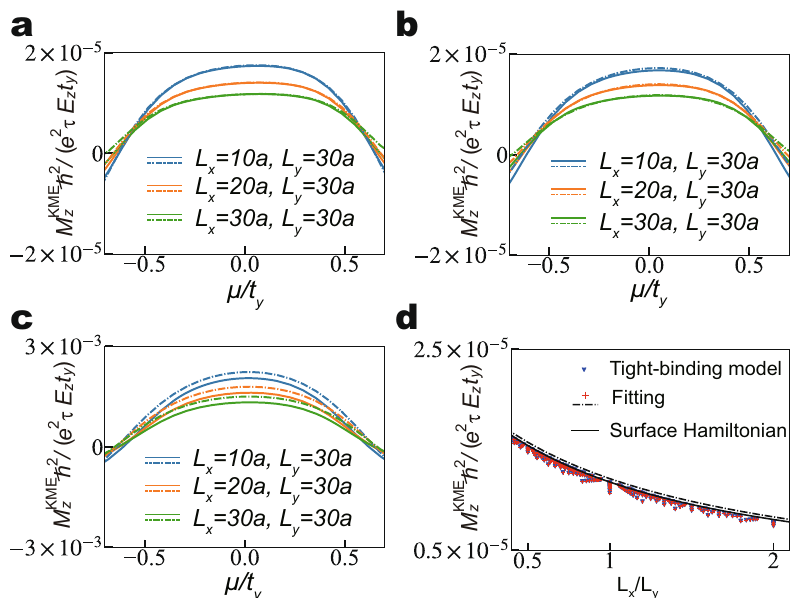
Fig. 4 Kinetic magnetoelectric effect (KME) in one-dimensional systems. a – c KME is calculated from two different methods; one is a direct calculation by Eq. (2) (solid lines) and the other is by a combination of calculation results for surfaces along xz and yz planes based on Eq. (7) (dashed lines). Parameter values are ( a ) t x = t y = m = b x = b y , t 3 = 0.001 t y and t 4 = 0.15 t y , ( b ) t x = b x = 1.1 t y , t y = b y = m , t 4 = 0.15 t y and t 3 = 0.001 t y , and ( c ) t x = t y = m = b x = b y , t = 0.15 t y and t = 0.1 t y . The results are shown for L x = 10 a (blue), L x = 20 a (orange), and L x = 30 a (green), while L y is fi xed to be 30 a . d Dependence of 4 3 the KME on the aspect ratio within the xy plane with parameters t x = b x = 1.1 t y , t y = b y = m , t 4 = 0.15 t y , t 3 = 0.001 t y , and μ = 0. Blue points represent the result of direct calculation by Eq. (2) for various system sizes. With parameter values t x = b x = 1.1 t y , t y = b y = m , t 4 = 0.15 t y , t 3 = 0.001 t y , and μ = 0, we calculate the KME with various system sizes from Eq. (2). The system sizes are ( L x , L y ) ∈ {10 a , 12 a , … , 38 a } × {10 a , 12 a , … , 38 a }. Red points represent the result of fi tting the numerical results of Eq. (2) with the fi tting function in Eq. (13), and its limit for L x , L y → ∞ is shown as the dashed line. The solid line represents the results of the surface theory in Eq.